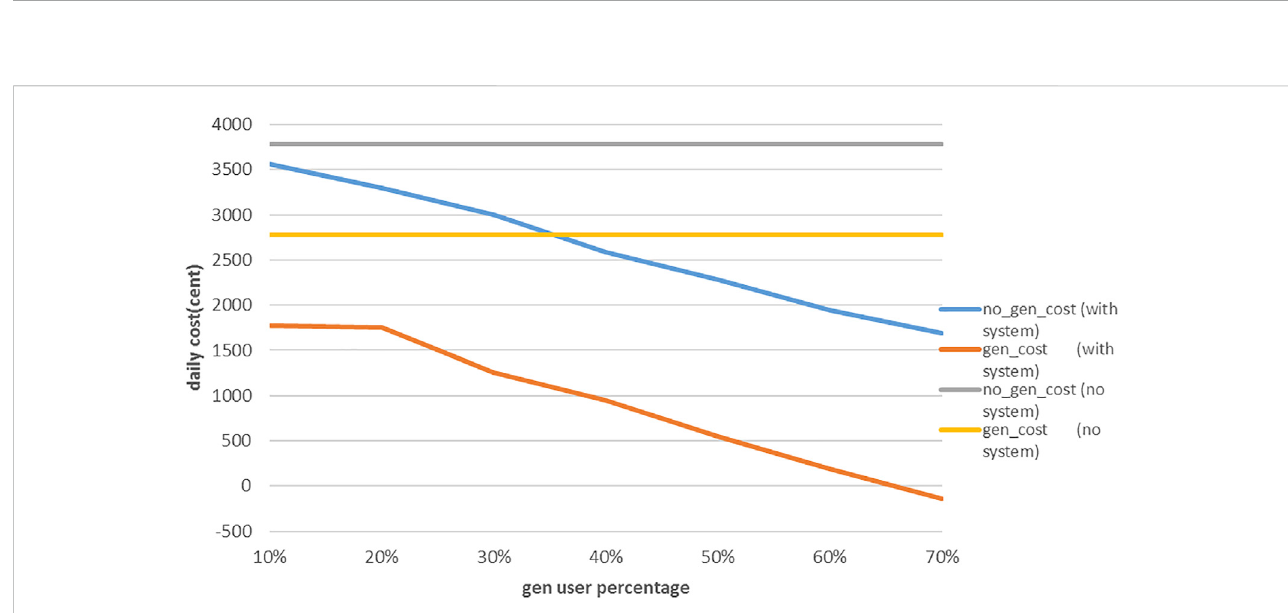
FIGURE 10 Average cost with different